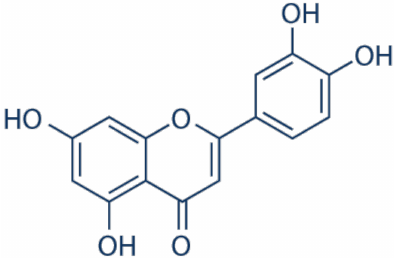
Figure 4. The chemical structure of luteolin.